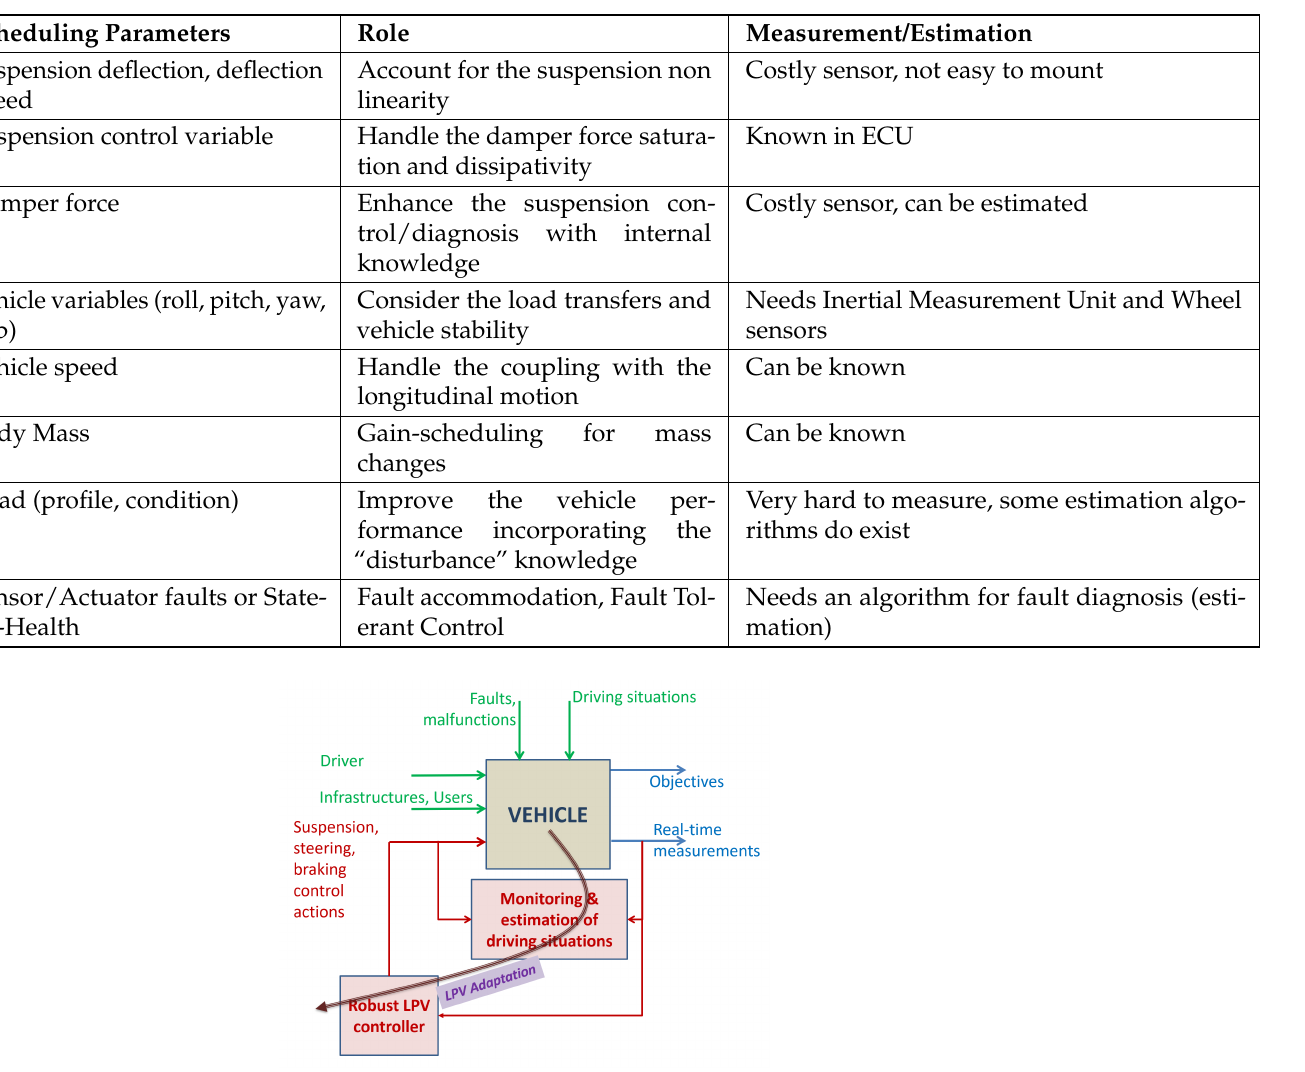
Table 3. Type and role of scheduling parameters.